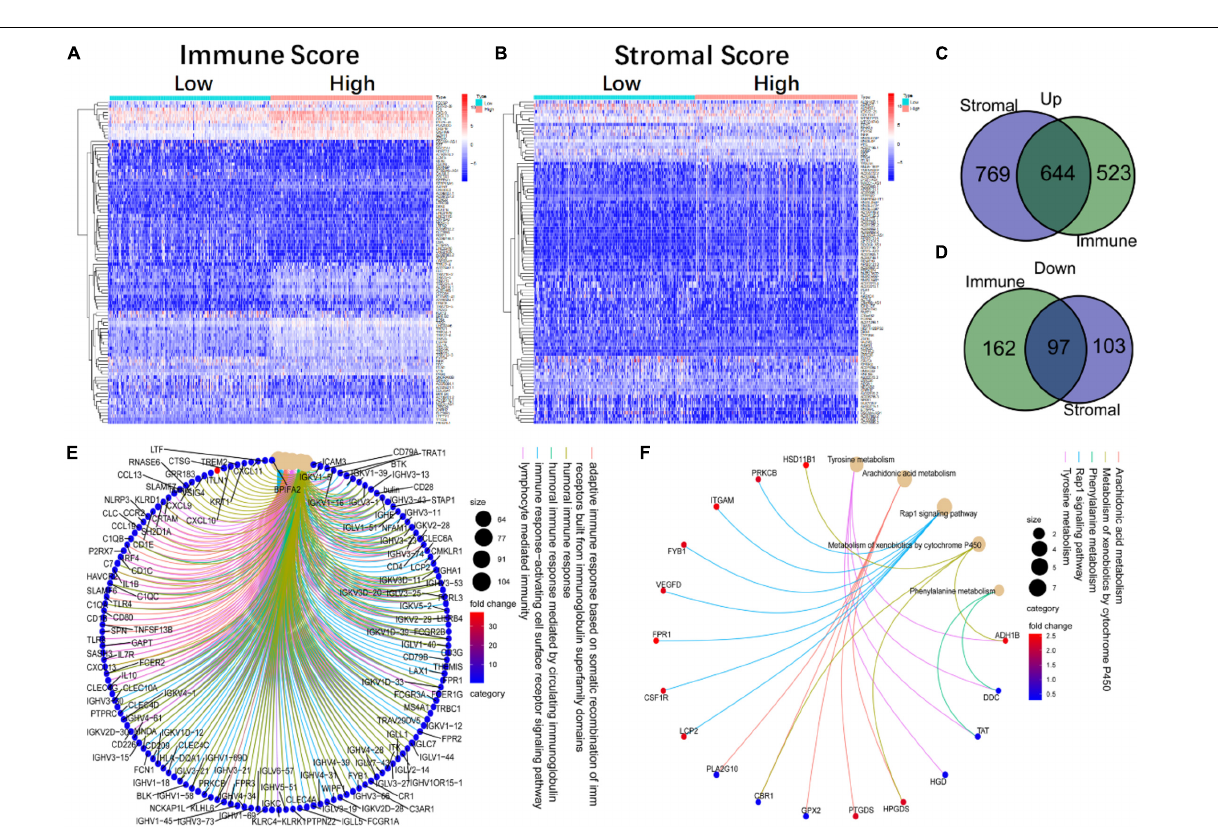
FIGURE 2 | The heatmap, Venn diagram, GO, and KEGG enrichment analysis of DEGs in immune and stromal components. (A) The heatmap of DEGs in high and low immune score groups. (B) The heatmap of DEGs in the high and low stromal score groups. (C,D) The Venn diagram of up-regulated and down-regulated genes co-expressed in immune and stromal component. (E,F) The GO and KEGG enrichment analysis of 741